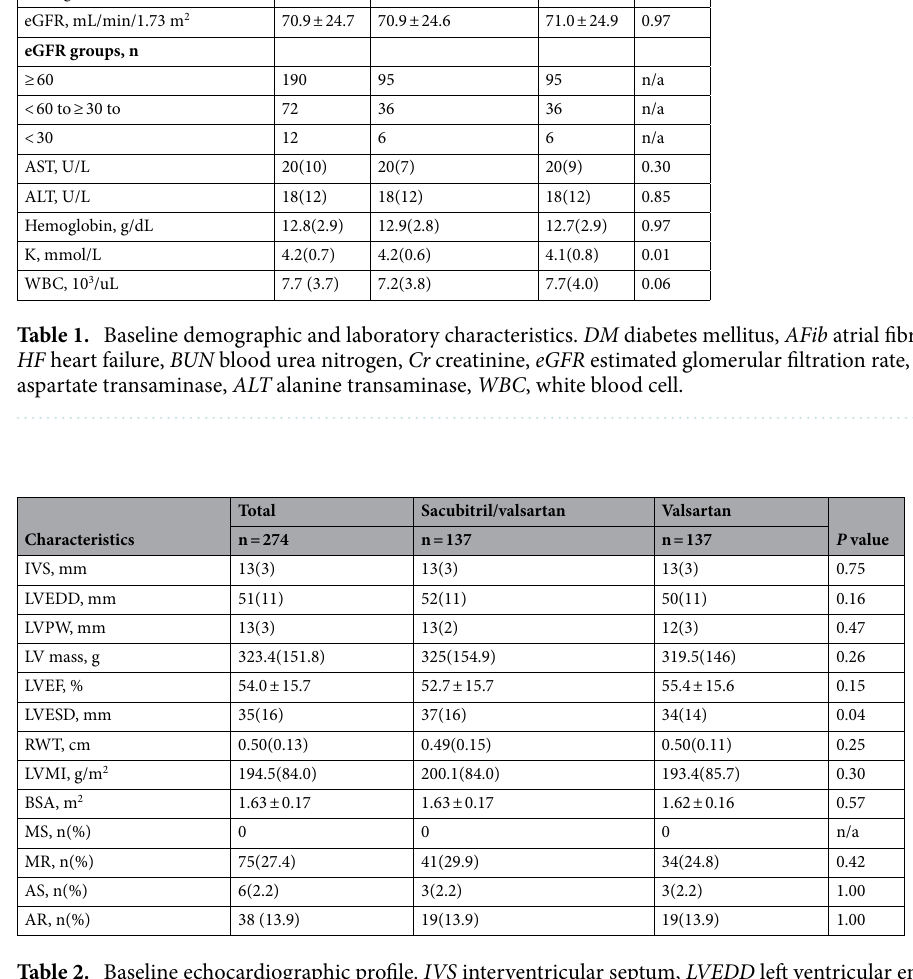
Table 2. Baseline echocardiographic profile. IVS interventricular septum, LVEDD left ventricular end- diastolic diameter, LVPW left ventricular posterior wall, LV mass left ventricular mass, LVEF left ventricular ejection fraction, LVESD left ventricular end-systolic diameter, RWT relative wall thickness, LVMI left ventricular mass index, BSA body surface area, MS mitral stenosis, MR mitral regurgitation, AS aortic stenosis, AR aortic